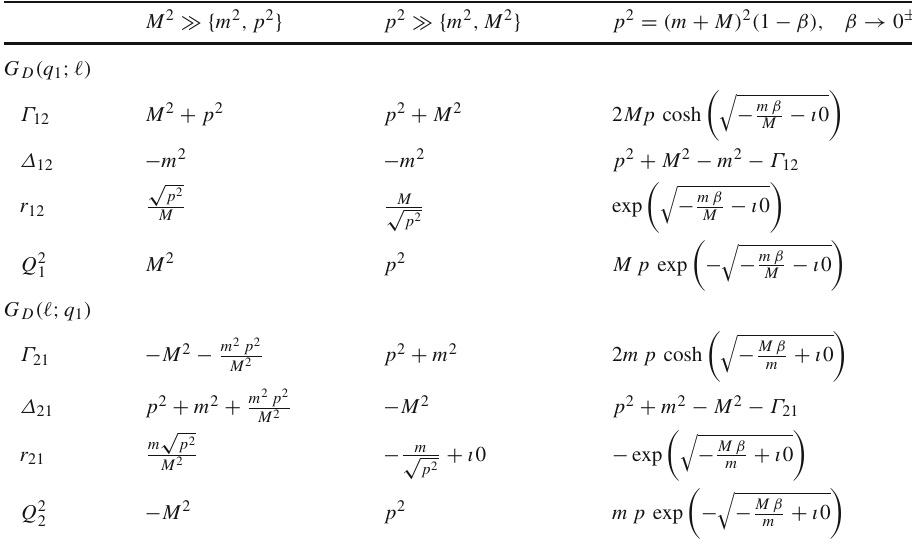
Table 1 The coefficients of the asymptotic expansions for the scalar two-point function in different kinematical limits